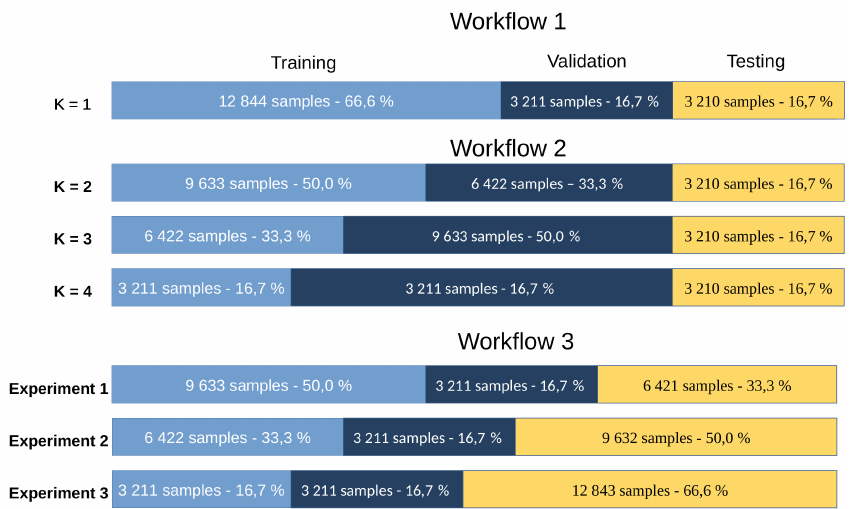
Figure 11. Variation of training/validation set and testing image set for the 3 workflows. The training/validation set is used for the cross-validation as shown in Figure